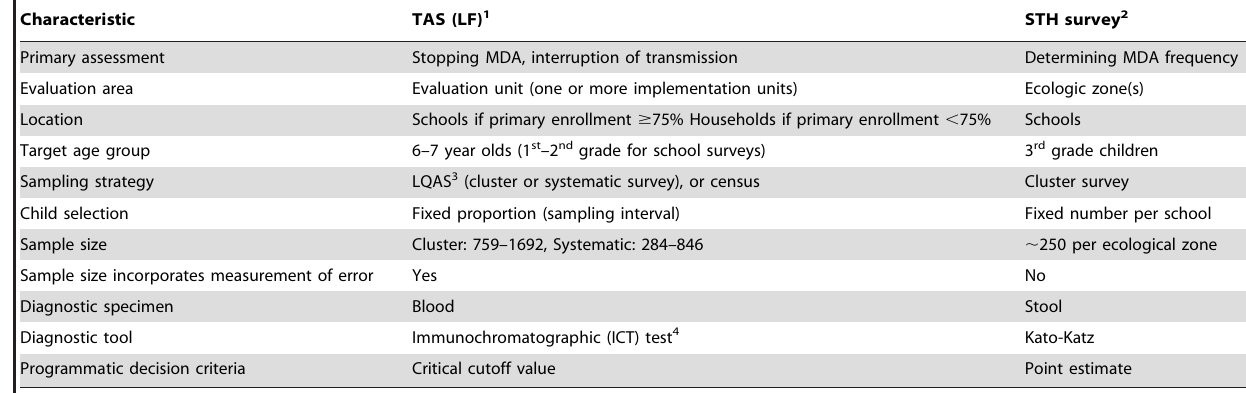
Table 1. Comparison of TAS and STH survey criteria.